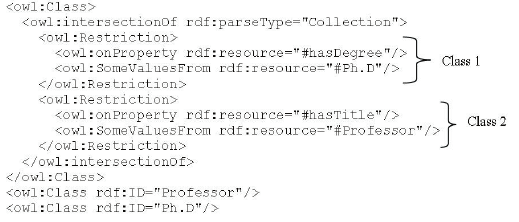
Fig. 2. An example of nestedly defined concept